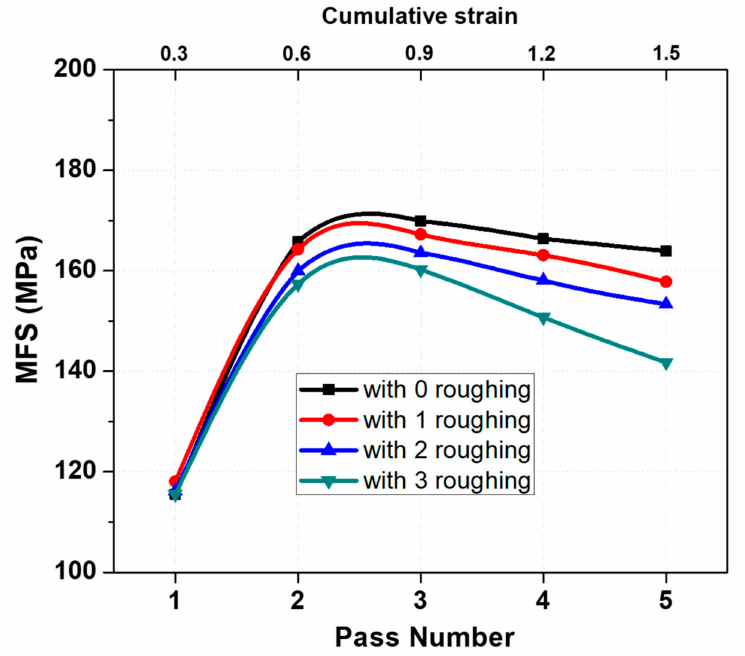
Figure 7. Mean flow stress (MFS) curves derived from the stress–strain curves of Figure 3. The MFSs increase from the 1st to the 2nd pass followed by softening in the succeeding passes, which can be accounted to the formation of DT ferrite during each